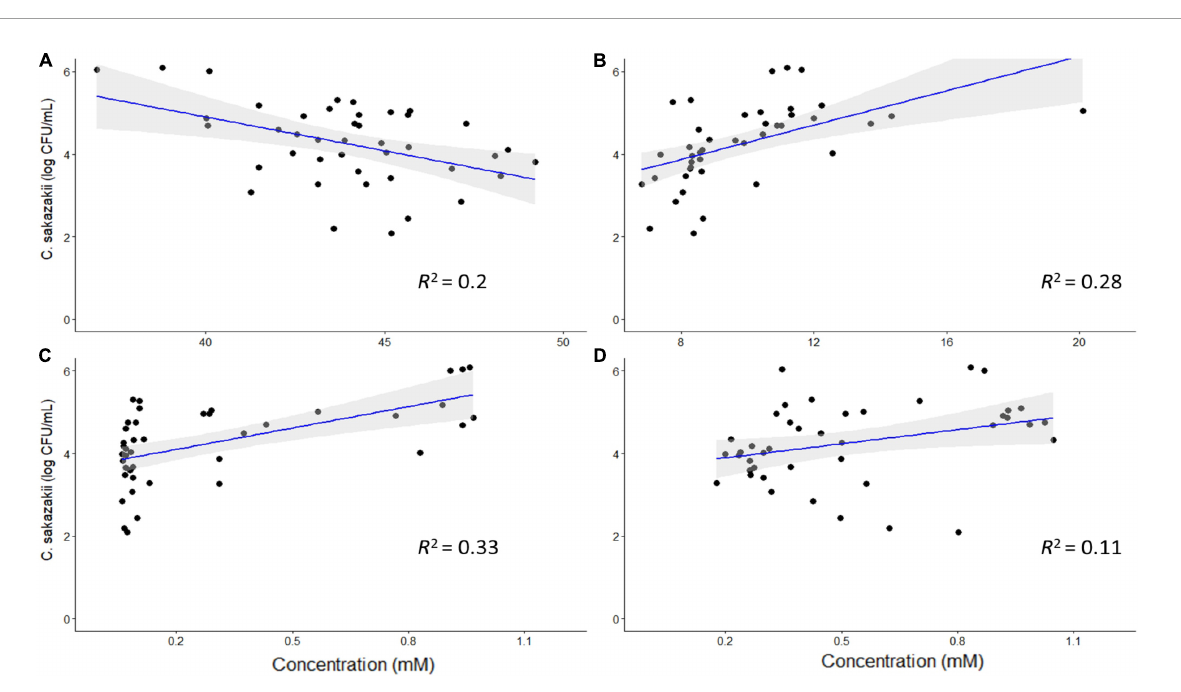
FIGURE5 Regression analysis of C. sakazakii levels with concentrations (mM) of acetate (A) , ethanol (B), acetone (C) , and glycine (D) . There is a significant correlation between the concentrations of these metabolites and C. sakazakii levels ( p < 0.05). Acetate is negatively correlated with C. sakazakii, whereas the other metabolites are positively